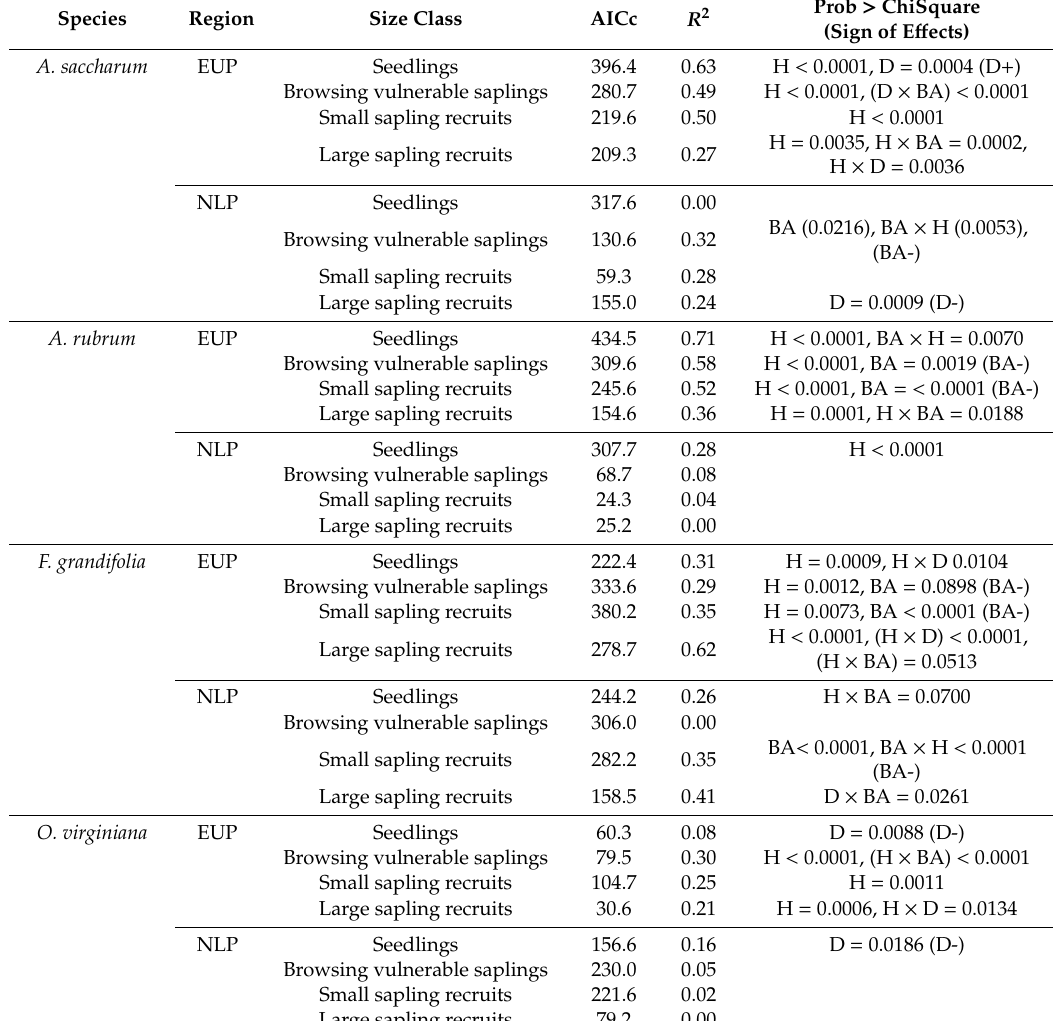
Table 3. Models of tree regeneration counts by size class for the four most abundant species using generalized negative binomial regression: Models are for species, regeneration size class, and region combinations with su ffi cient data for modeling. H = habitat type, D = deer use, BA = current basal area. Model summaries shown are those with the best supports. Factors shown are those retained in final models using elastic net estimation and AICc validation with Prob > ChiSquare < 0.10. Signs of main e ff ects ( + or -) are in